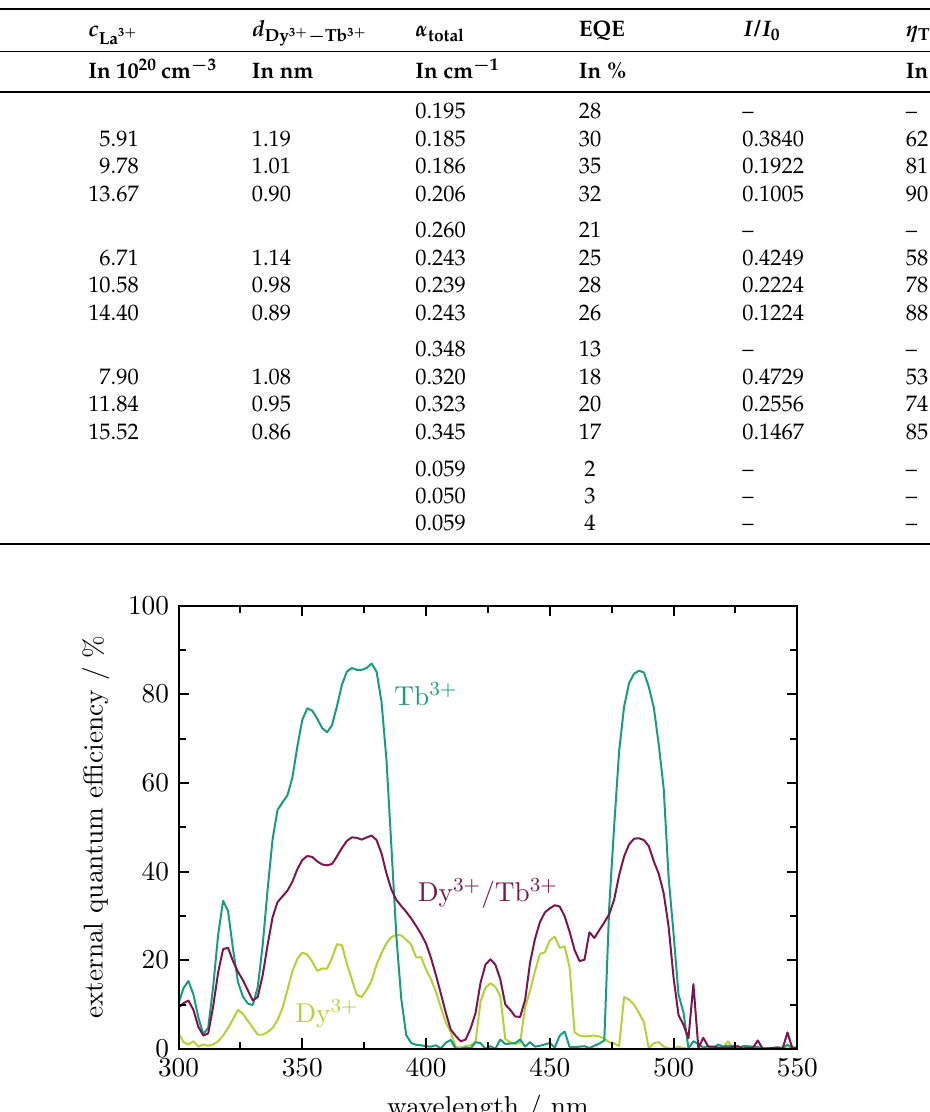
As 452 nm is a common laser wavelength, the behavior of the double-doped samples under blue excitation is investigated. The photoluminescence emission spectra of the Dy 3 + and Tb 3 + single-doped samples as well as the Dy 3 + / Tb 3 + double-doped sample are shown in Figure 6a. The Dy 3 + doped glass (light green curve) shows four maxima at 483 nm, 575 nm, 663 nm, and 753 nm, which belong to transitions from the excited state 4 F 6 H 6 H 6 H 6 H 9/2 to the ground states 15/2 , 13/2 , 11/2 , and 9/2 , respectively [9]. The mixture of the largest emission band at 575 nm and the second largest emission band at 483 nm results in the green–yellowish color impression of Dy 3 + . The Tb 3 + doped glass (dark green curve) also shows four maxima, namely at 490 nm, 542 nm, 585 nm, and 622